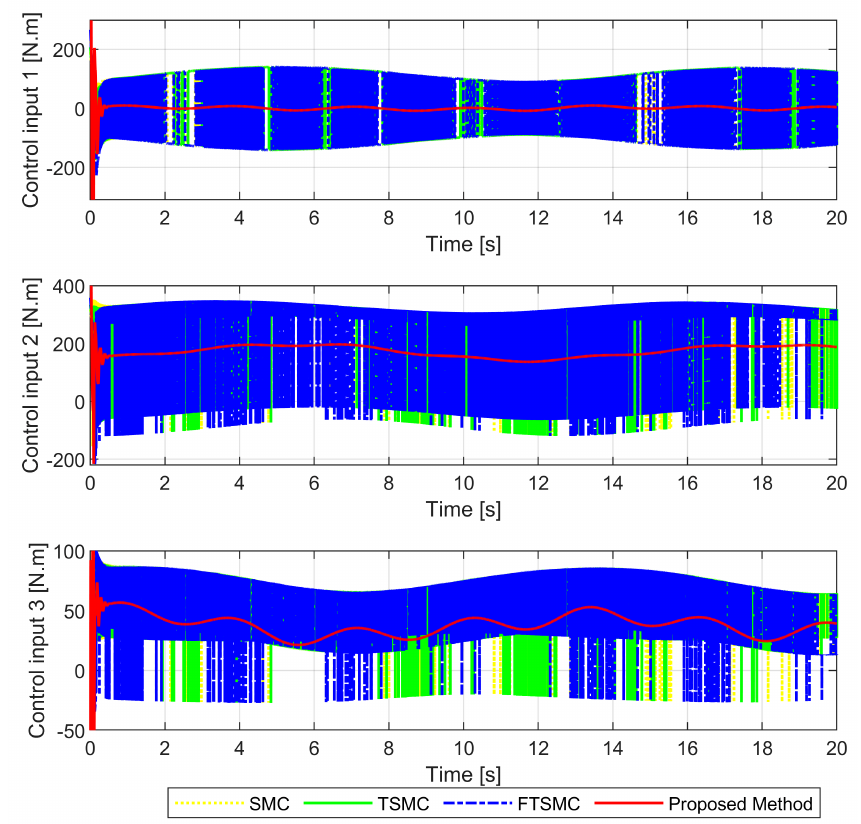
Figure 9. Analysis of chattering behaviors among the four approaches with their respective con- trol